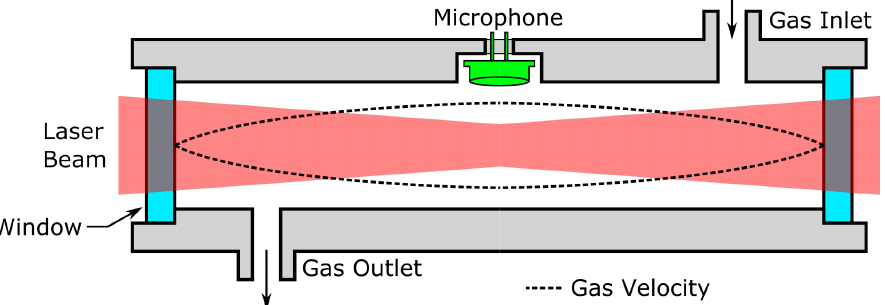
Figure 3. Outline schematic of an organ-pipe-like resonant acoustic cell. The cell consists of a pipe closed at its two ends with optical windows. A laser beam at 4.26 µm is then pulsed at the resonant frequency of the pipe, which forms a λ /2 resonator. For instance, if a 32,768 Hz quartz tuning fork is used, λ ≈ 10 mm and a pipe length of ∼ 5 mm would be ideal. A velocity-sensitive microphone may be placed at half the pipe as depicted. Alternatively, a pressure-sensitive microphone would rather be placed near one of its